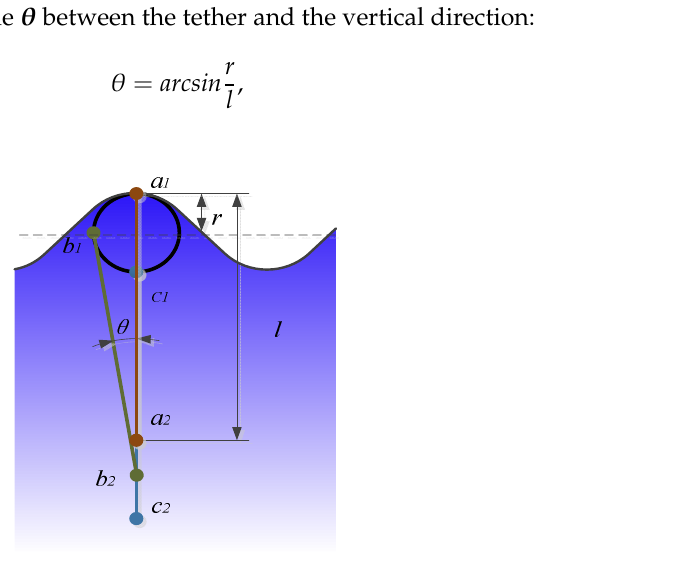
Figure 7. Basic function and form of the blade: ( a ) free swing angle range of one of the blades; ( b ) the directions of the upper blade group and lower blade group rotate in opposite directions.